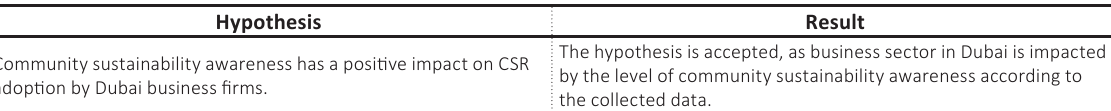
Figure 2. Answer to the question “Can you tell the difference between sustainable business firms and non-sustainable business firms?” Table 2. Hypothesis testing